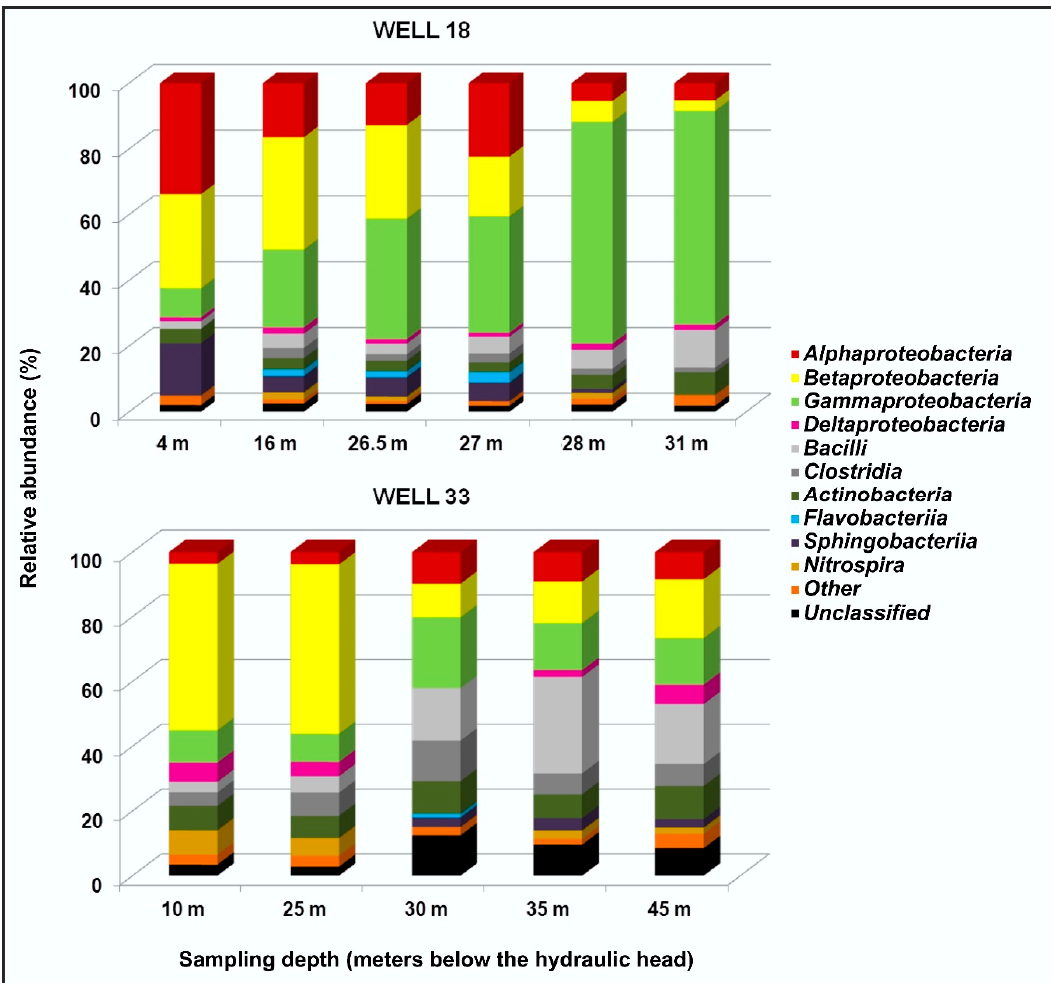
Figure 8. Class level microbial community composition in water samples collected from wells 18 and 33. Classes with relative abundance <1% are grouped in the category “Other”.